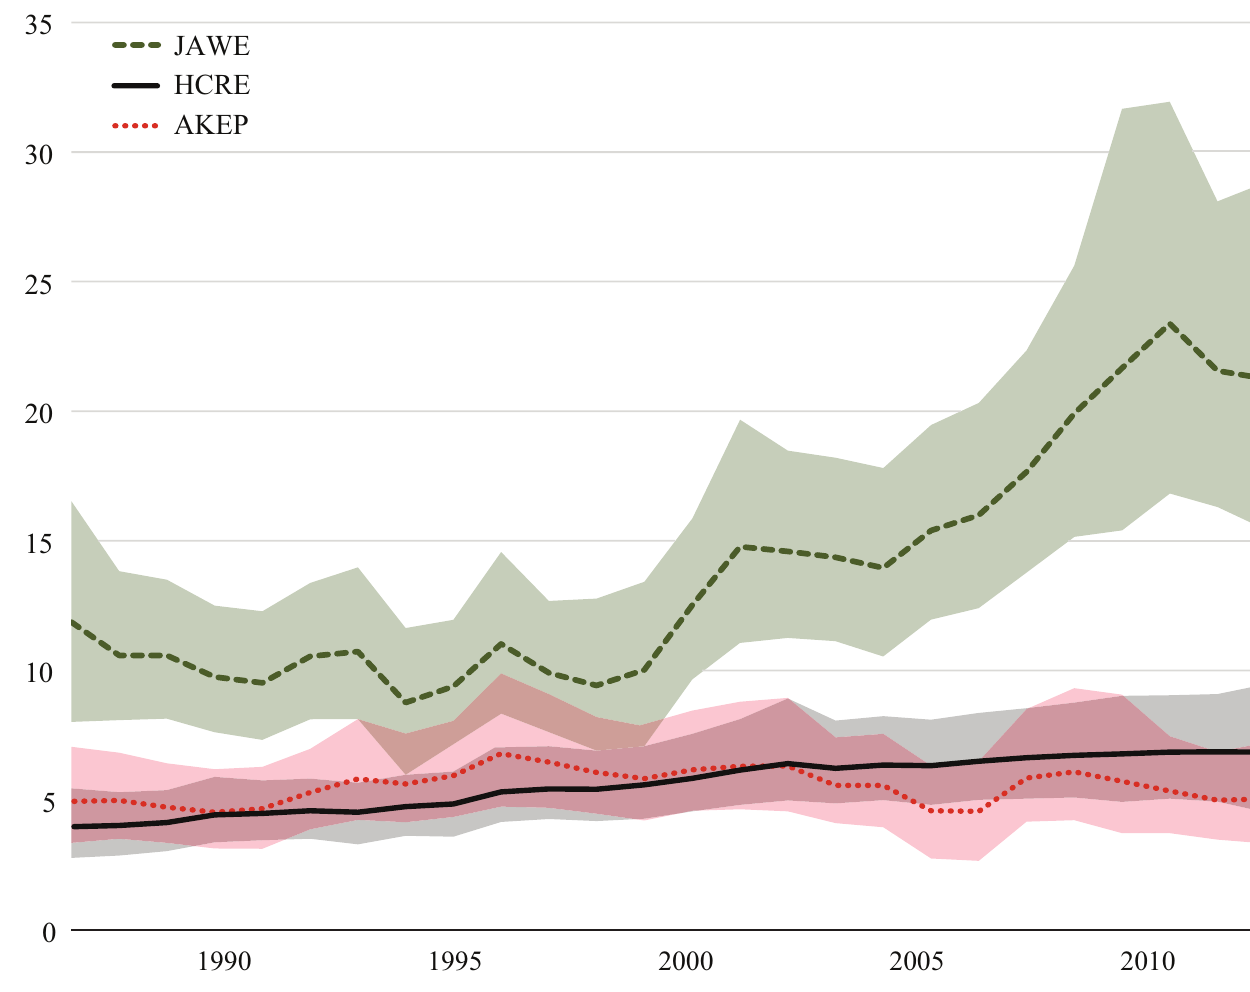
Fig 3. State-space abundance estimates( ± 95% credible interval) of the Hawai‘i Creeper (HCRE, black solid line), Hawai‘i ‘ Ā kepa(AKEP, red dotted line) and the Japanese White-eye (JAWE, green dashed line) over 25 years(1987–2012) in the open forest stratum of Hakalau Forest National Wildlife Refuge. Modifiedfrom Camp et al.